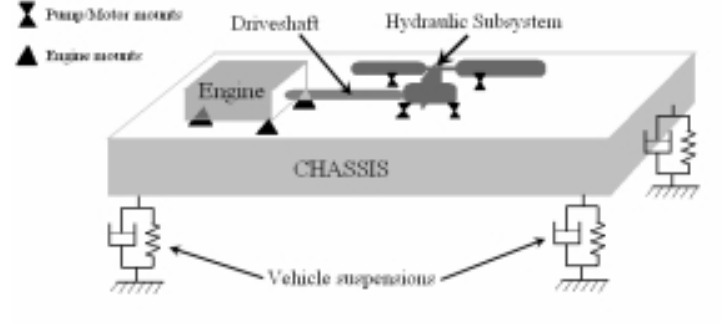
Fig. 3. Full-vehicle model of a parallel